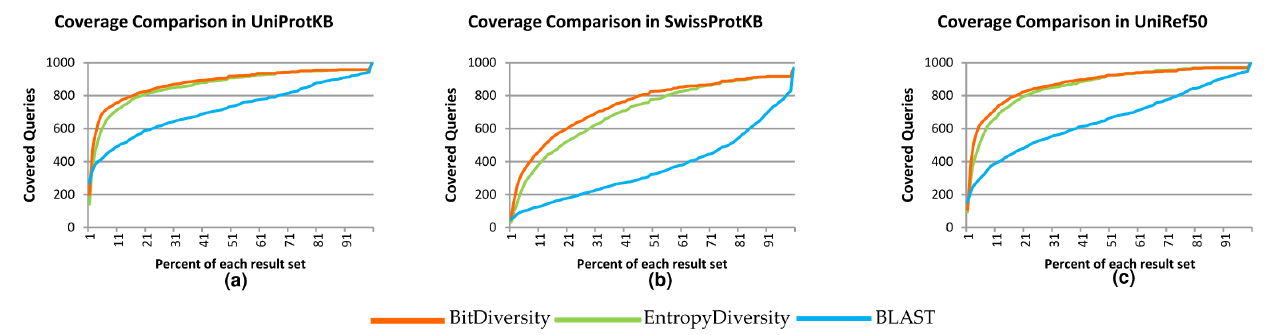
Fig. 7. Coverage comparison graphs between original BLAST and diversity based approaches result sets in different databases: UniProtKB, SwissProtKB and UniRef50. The x axes represent the number of result sets that cover all sections of the given queries. The y axes show how much percent of a result set is